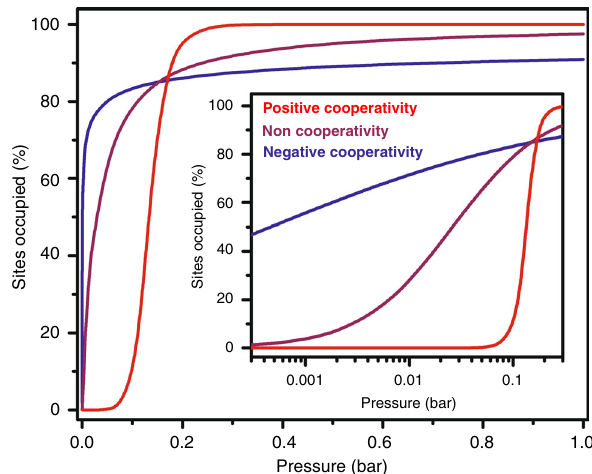
Fig. 1 Illustration of adsorption isotherm variability with cooperativity. Isotherms of positively cooperative (red line), noncooperative (purple line), and negatively cooperative (blue line) systems exhibit signi fi cant differences in shape, due to the nature of the adsorbate-adsorbent interactions. In particular, negatively cooperative systems can reach half occupancy at signi fi cantly lower pressures than noncooperative and positively cooperative systems but generally require much higher pressures to reach saturation. The inset graph displays the low pressure regime (<0.2 bar) on a logarithmic scale to highlight differences in isotherm